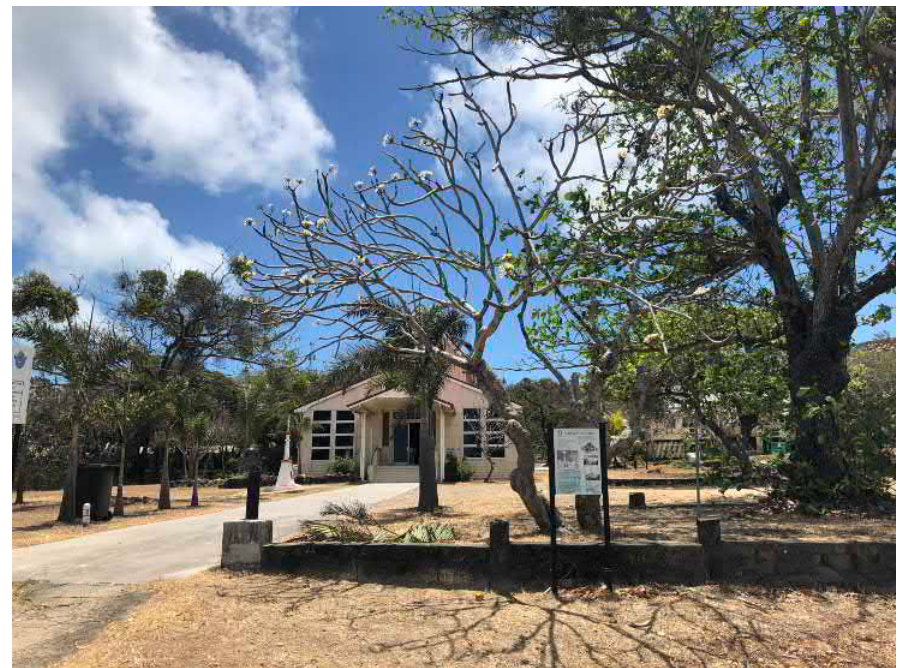
Figure 2: Frangipani trees outside the Anglican Quetta All Souls Memorial Cathedral, Thursday Island. (Photo: Anna